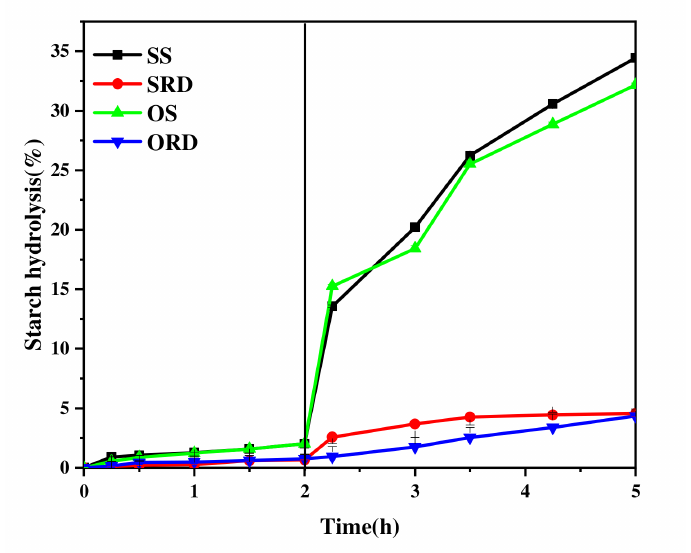
Figure 4. Digestibility changes in sorghum/oat starch and sorghum/oat resistant dextrin. SS: sorghum starch; SRD: sorghum resistant dextrin; OS: oat starch; ORD: oat resistant